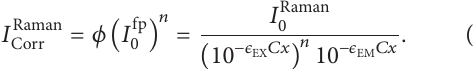
AGGREGATE (830 nm) measurements for the three